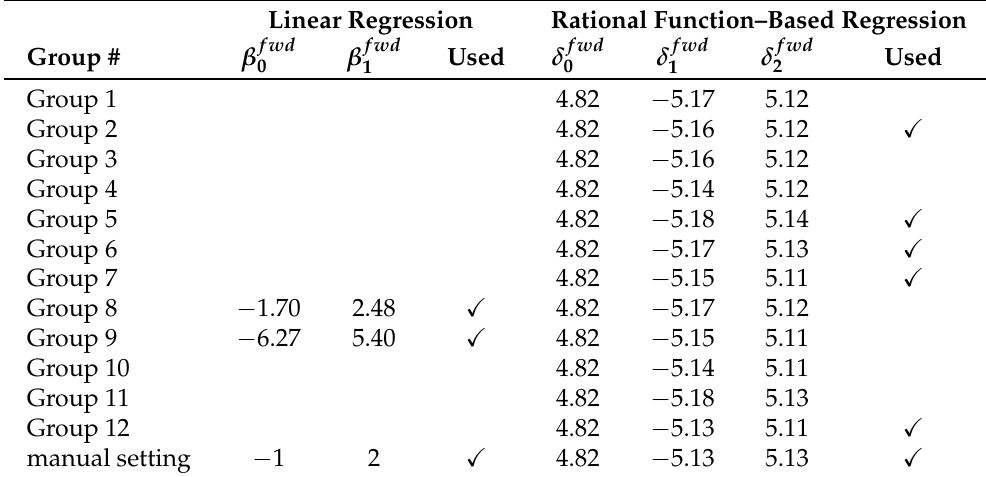
Table 3. Candidate coefficients for linear and rational function–based